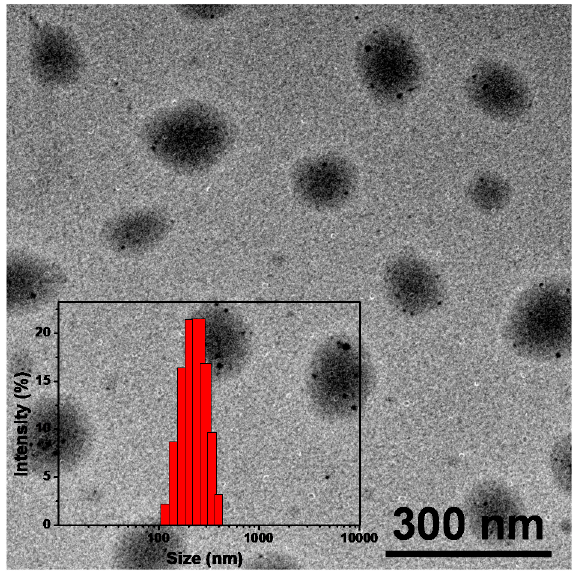
Figure 3. TEM image of TNPs and typical size distributions of TNPs (insert).